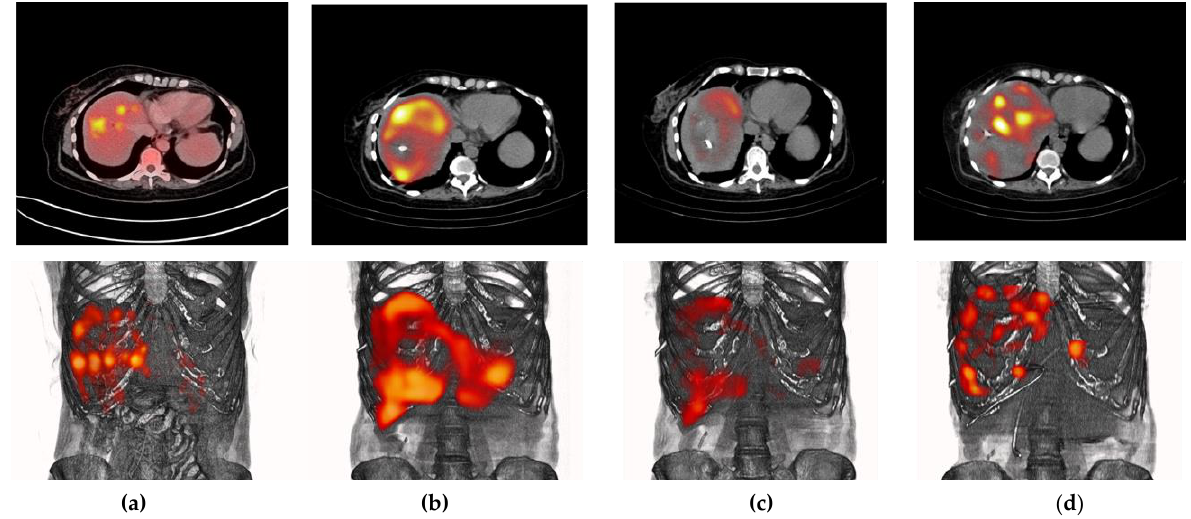
Figure 5. Different molecular images (top: axial sections; bottom: PET/CT or SPECT/CT images) of a patient with multiple colorectal liver metastases (PSMA-positive): ( a ) [ 18 F]FDG PET/CT images acquired on 27 August 2021; [ 99m Tc]Tc-iPSMA SPECT/CT images at ( b ) 3 h and ( c ) 24 h post-injection